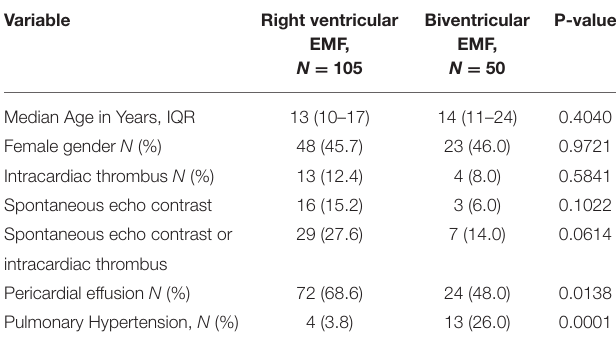
TABLE 3 | Comparison of cases with right ventricular EMF vs. those with biventricular EMF.